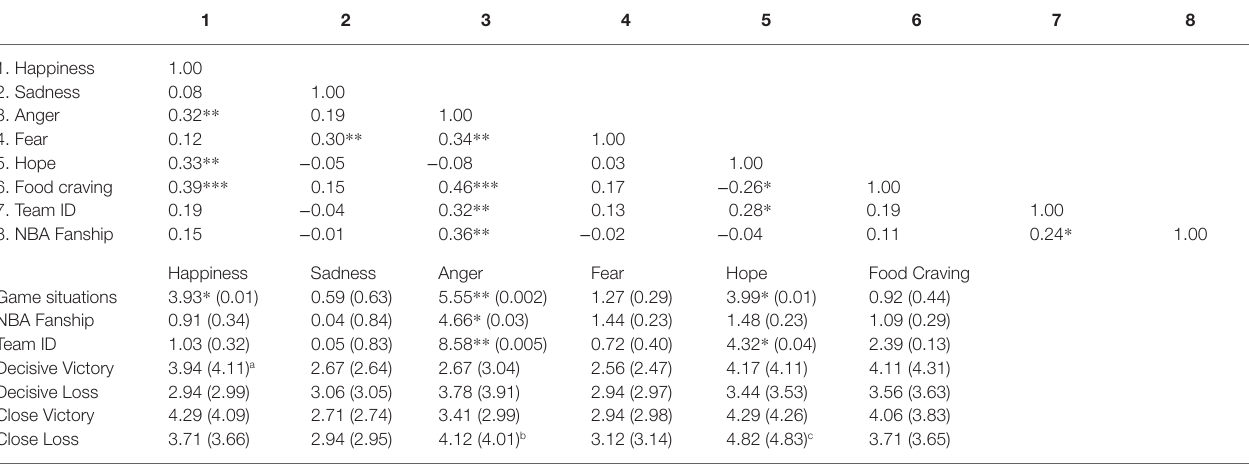
TABLE 1 | Correlation coefficients, F-statistics (Sig.), and raw means (least square adjusted means;